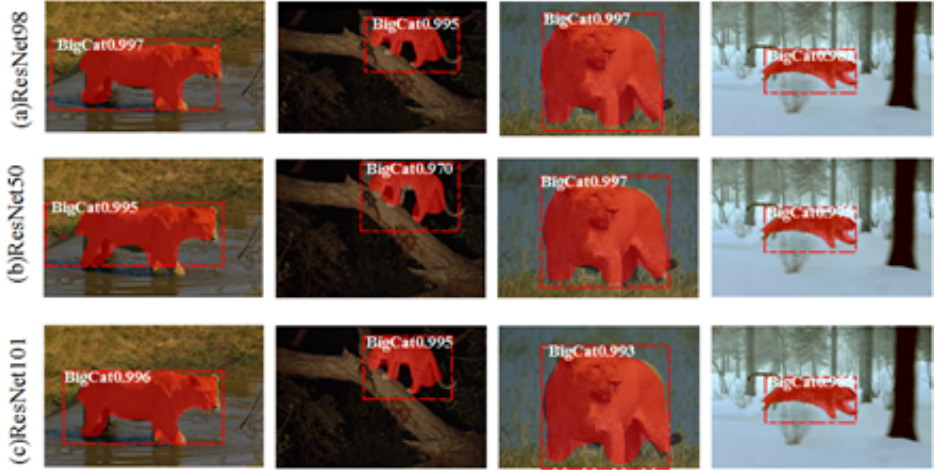
Figure 9. Instance segmentation results for four different actions (first row: ResNet98, second row: ResNet50, and last row: ResNet101; from left to right: ambling, two different types of standing, and galloping).